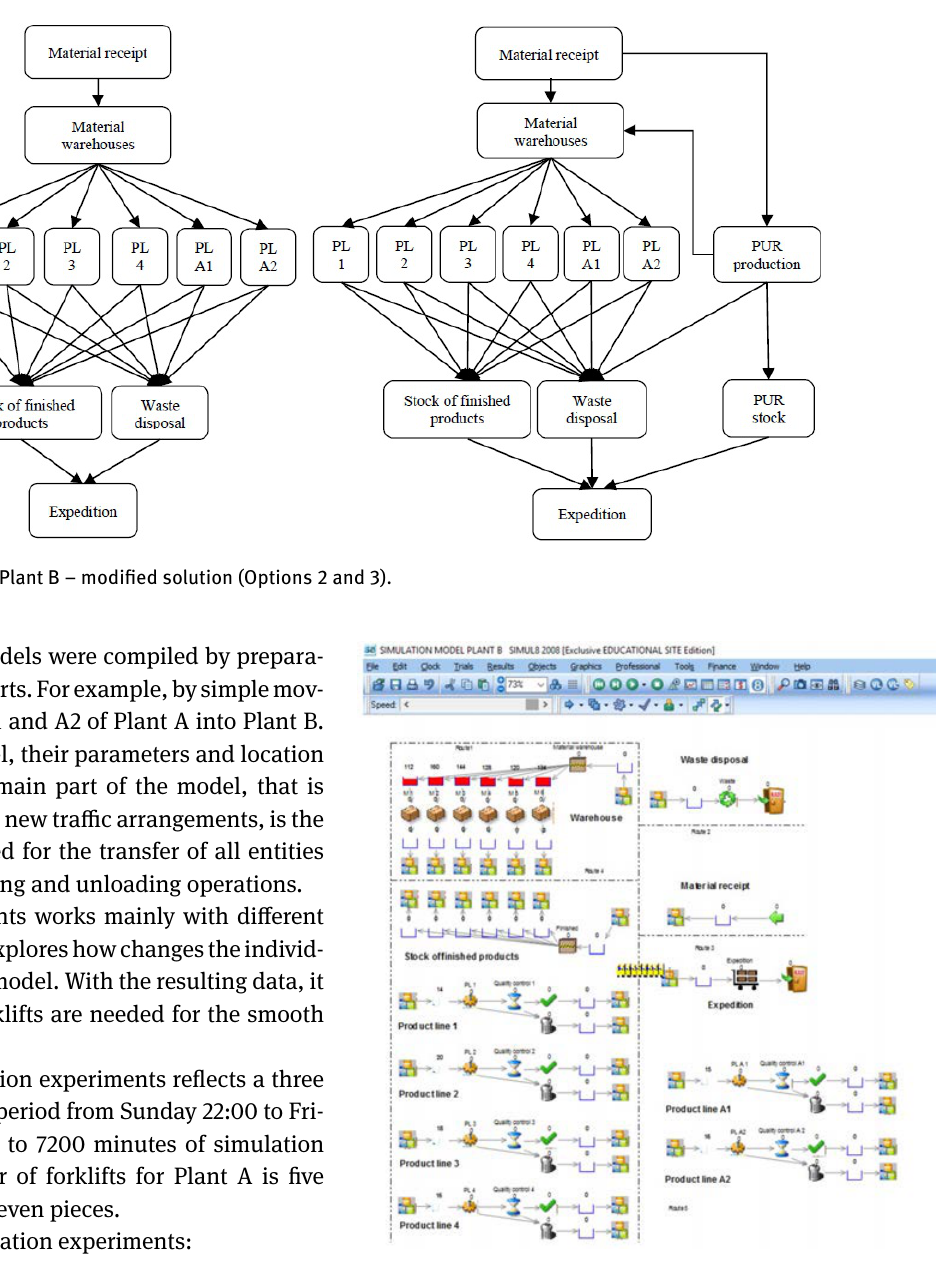
Figure 3: Simulation model of Plant B Option